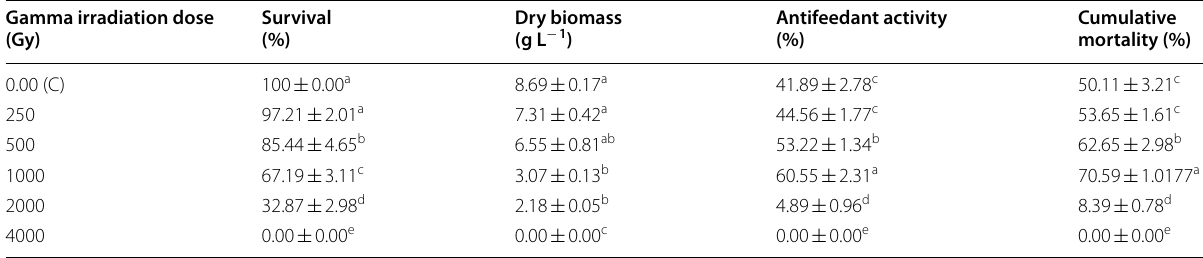
Table 3 Effect of different doses of gamma irradiation on survival (%), dry biomass (g L − 1 ), antifeedant activity (%), and cumulative mortality (%) of the 3rd instar Spodoptera littoralis larvae feeding on castor leaves treated with methylene chloride extract of A. flavus AUMC14507